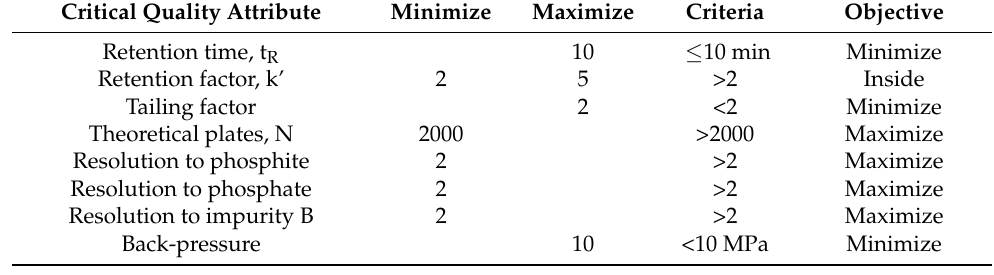
Table 4. Set quality attribute ranges, criteria, and objectives for foscarnet peak characteristics during design space evaluation.